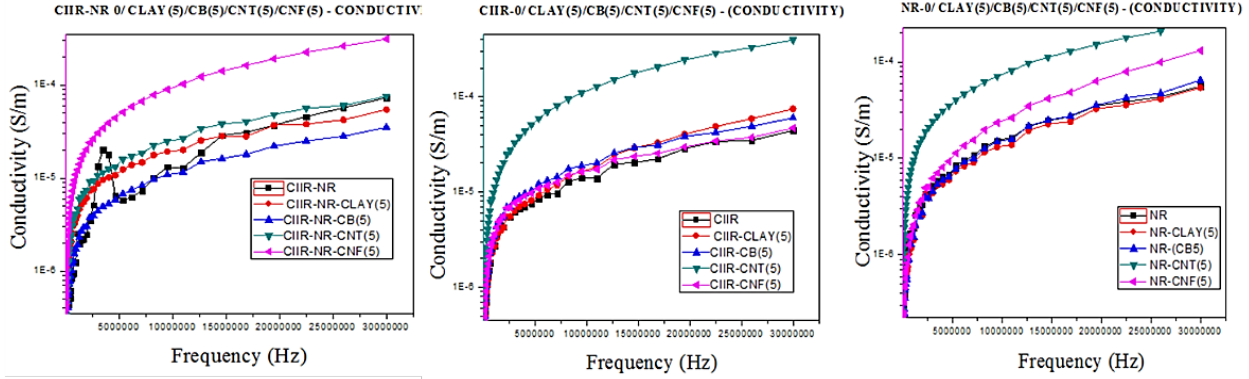
Figure 9. Resistivity – composition graph of hybrid filler composition and blend rubber nanocom- posite in NR/CIIR matrix.